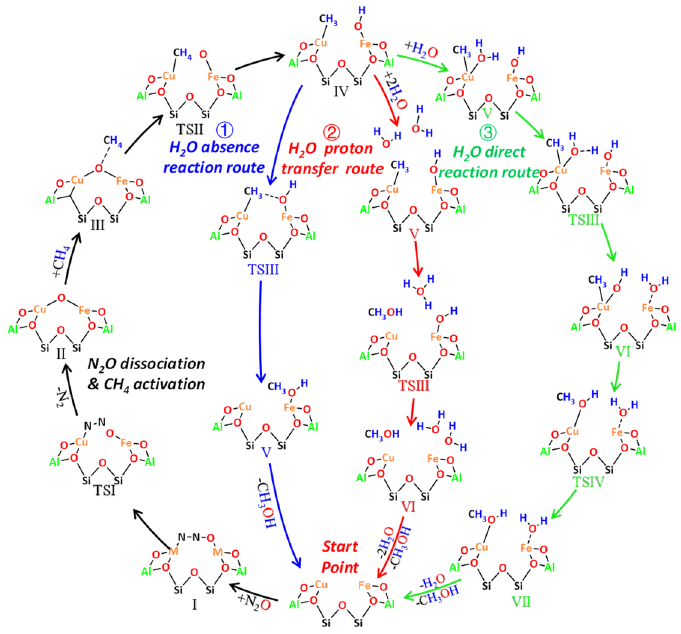
Scheme 1. Schematic diagram of proposed N 2 O DMTM reaction mechanism over the best-performing sample of Fe 0.6% Cu 0.68% -BEA in the presence and absence of H 2 O; specifically, after the initial N 2 O dissociation and CH 4 activation steps (black line), three types of routes were proposed, namely: (i) in the absence of H 2 O (blue line); (ii) the H 2 O proton-transfer route (red line); and (iii) the H 2 O direct-reaction route. The chemical structure was labeled according to constructed models depicted in the energy diagrams of Figure 7 and Figure